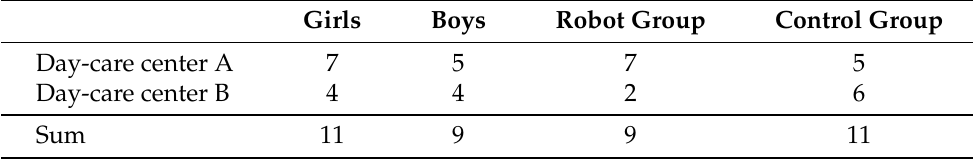
Table 1. Distribution of gender and trial groups over day-care centers.